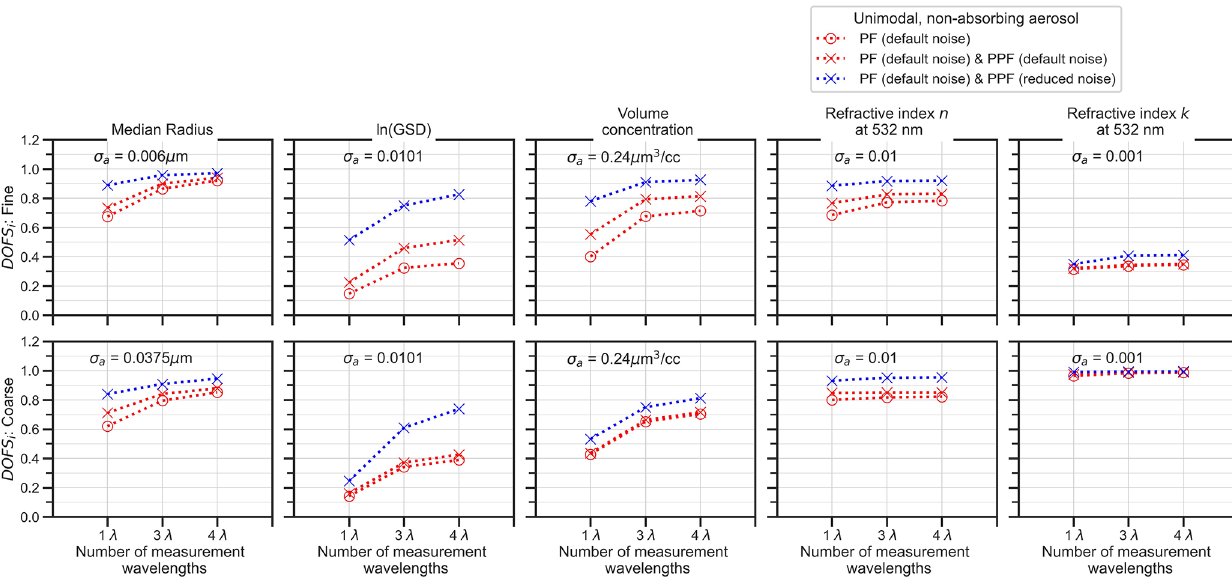
Figure 5. DOFS i values for specific aerosol parameters corresponding to the fine (upper row) and coarse (bottom row) unimodal, non- absorbing-aerosol test cases. The a priori variances ( σ a ) for each state space parameter are displayed as text boxes in each panel. These values were chosen according to the “high level of prior knowledge” selection method described in Sect. 3.3. The blue lines are the DOFS i values corresponding to a reduced PPF measurement noise level of 0.01, while the default noise is 0.056 (Eq. 9). The relative PF measurement noise level is 0.046 (Eq. 8) for all